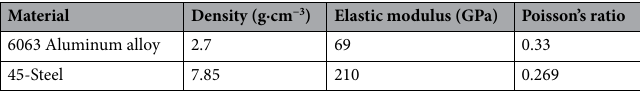
Table 5. Material parameters of 6063 aluminum alloy and 45 steel.